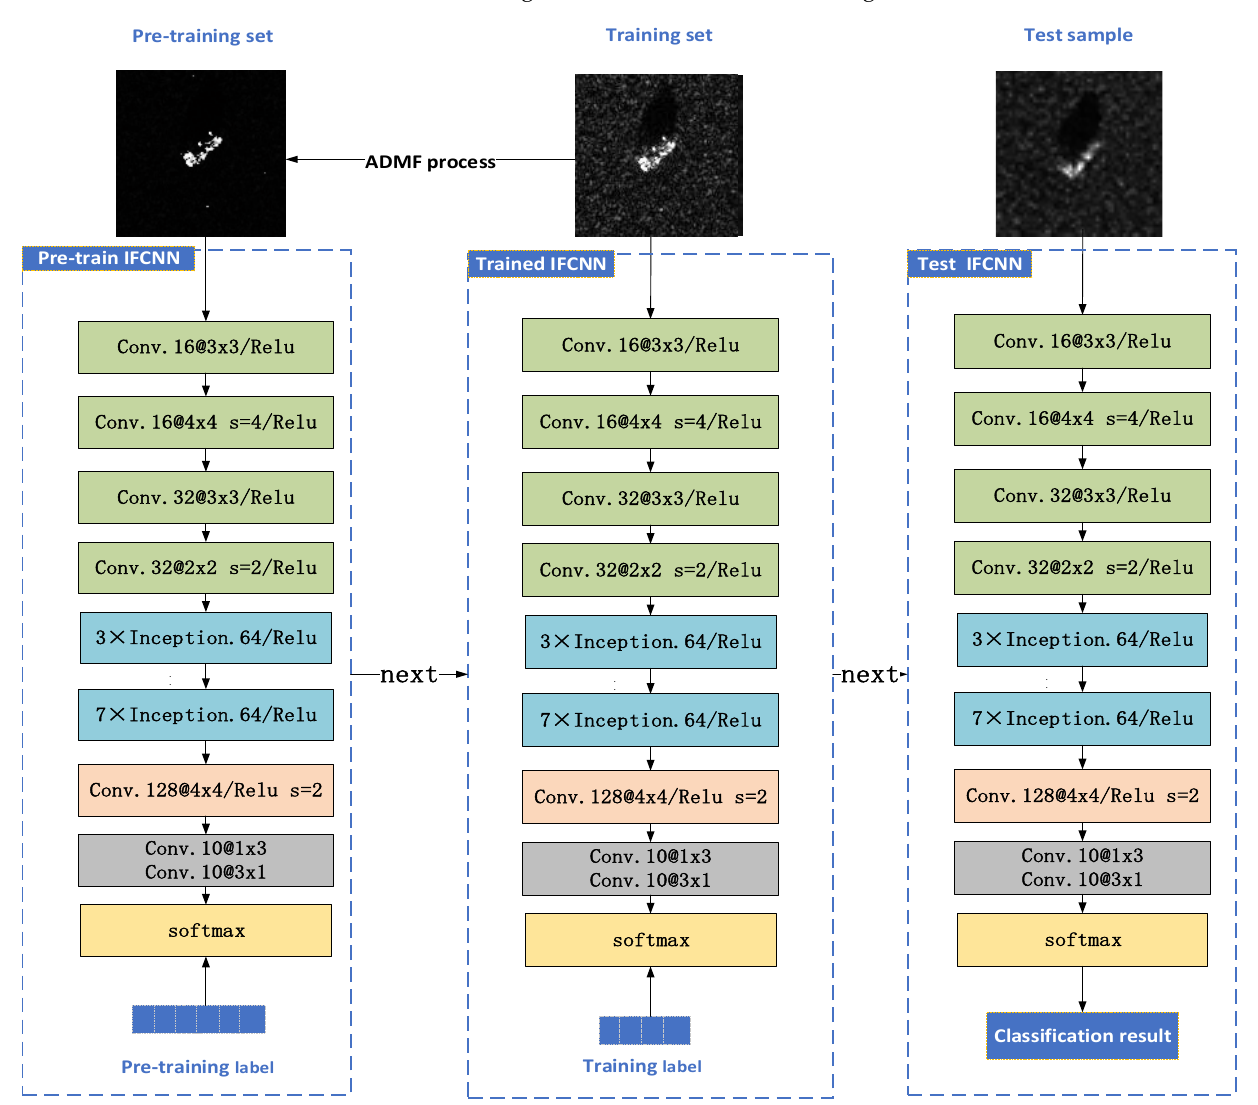
Figure 1. The workflow and overall structure of the ADMF-IFCNN recognition method.